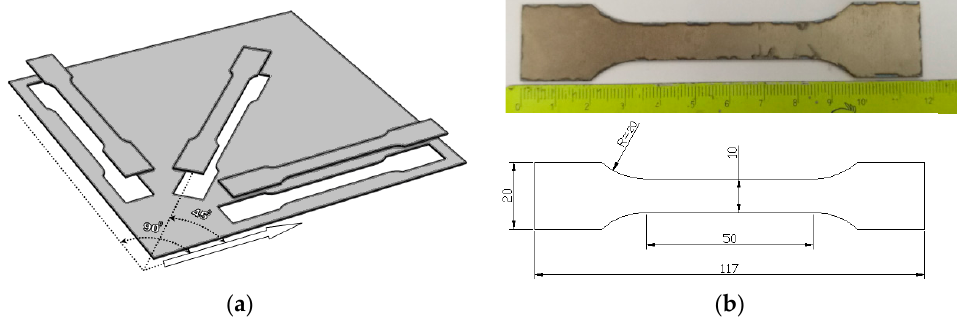
Figure 1. TA1 titanium alloy plate tensile test sample. ( a ) Locations of samples in different direc- tions. ( b ) Tensile sample size (in mm). ( b ) Tensile sample size (in